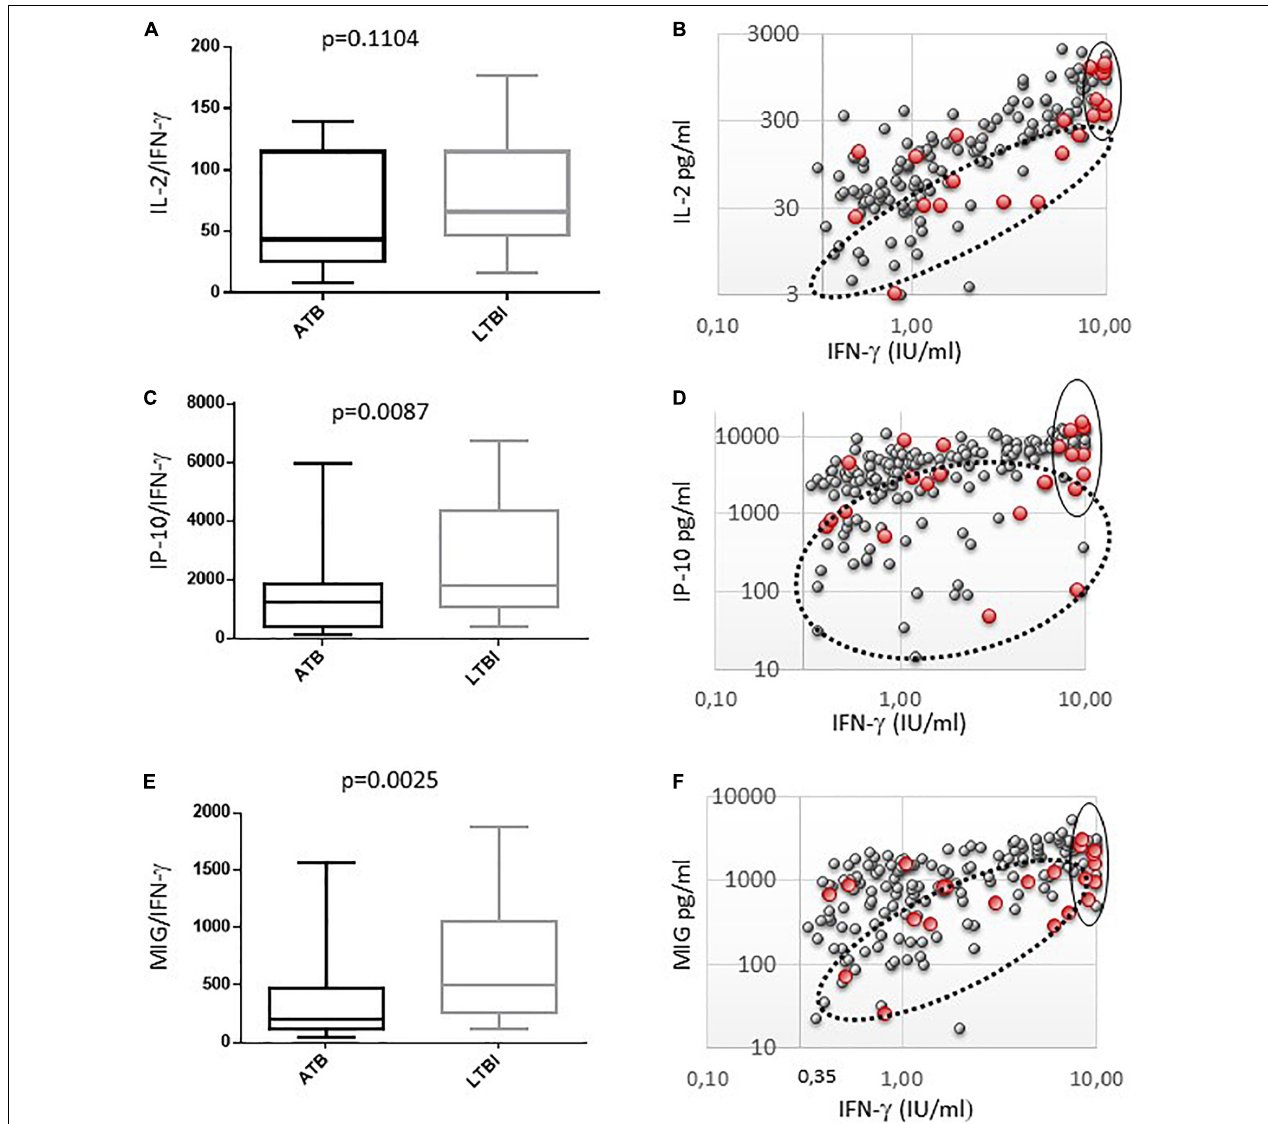
FIGURE 3 | Comparison of cytokine response in QFT supernatant between active (ATB) and latent TB infections (LTBI). (A,C,E) IL2, IP10 and MIG indexes (cytokine/IFN- γ ) are represented, ATB (black boxplots) and LTBI (gray boxplots). The median, IQR, 10th and 90th are shown in boxplots for each group. p -values are calculated with the Mann–Whiteny U test. (B,D,F) Biparametric graphs between the levels of IFN- γ (IU/ml) and cytokines (pg/ml) in QFT supernatants. ATB are represented by black circles and LTBI by gray circles. Risk groups are circled, subjects with ATB had more tend to have lower ratios of IL-2/IFN- γ , IP-10/IFN- γ , and MIG/IFN- γ (doted line circles), and high IFN- γ response (solide line